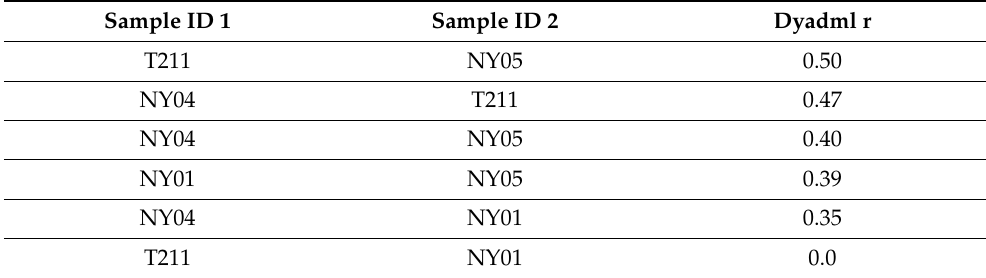
Figure 3. ( A ) Ancestry inference for autosomal ancestry proportions inferred from 26,763 SNP loci and two reference populations (pink, domestic dog; green, western coyote) with sex indicated on each pie chart (F, female; M, male); and ( B ) genetic relatedness coefficients estimated from 240 SNP loci genotyped in target coyotes sampled in the NYC metropolitan area. Inset shows four coyotes in a single location. Sample MEW009B was not plotted. Samples in panel ( B ) follow the same labels found in panel ( A ). Table 2. Pairwise relatedness (r) values from the dyadic likelihood (dyadml) estimator of the putative family group of coyotes sampled in the New York metro area genotyped for 240 SNP